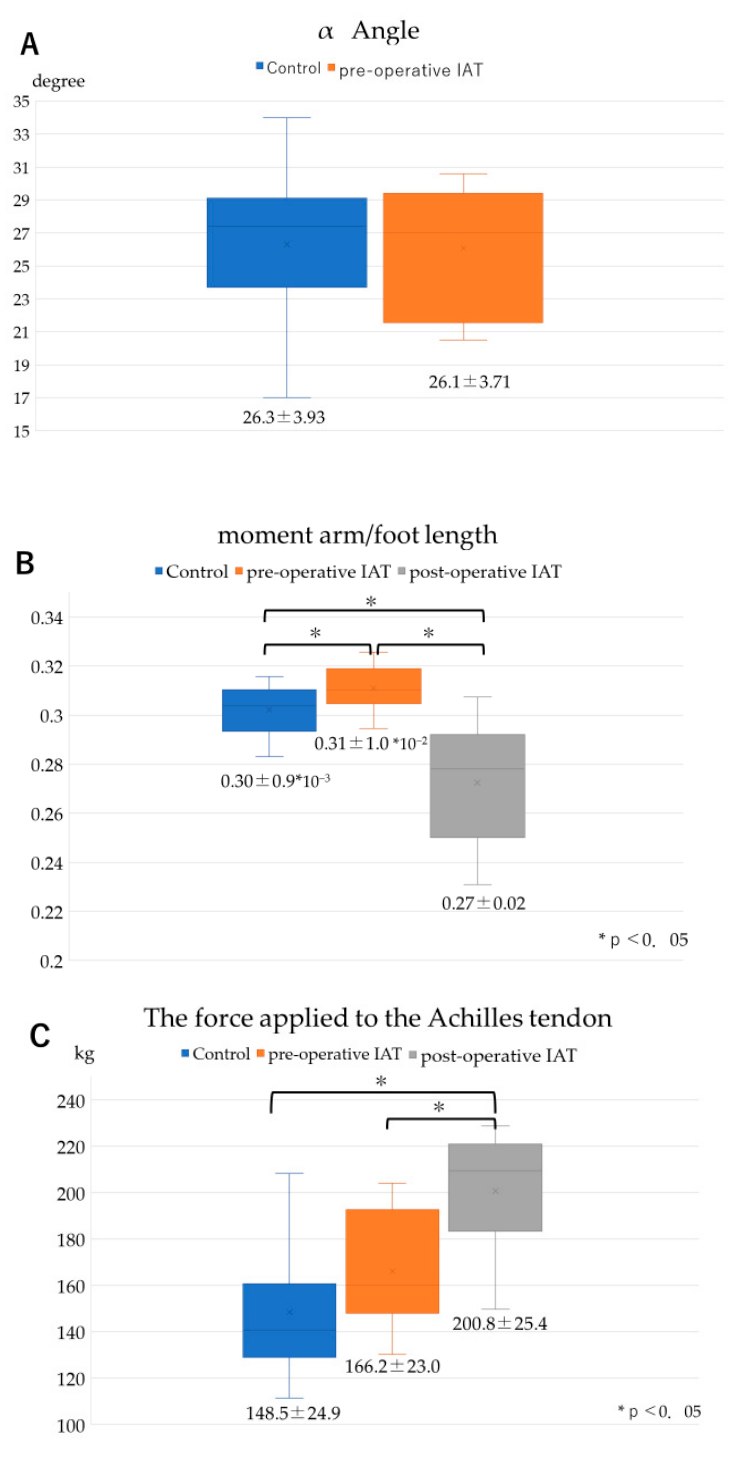
Figure 7. Radiographic Measurement. ( A ): Comparison of the α angle between the control and pre-operative IAT groups. ( B ): Comparison of the ratio of MA length / foot length between the control group, the preoperative IAT group, and the postoperative IAT group, showing significant differences between these groups ( p < 0.05). ( C ): Comparison of the force applied to the Achilles tendon between the control group, the preoperative IAT group, and the postoperative IAT group, showing that a significantly higher force to the Achilles tendon was observed in the IAT group postoperatively, compared to the other groups ( p < 0.05). Values are given as mean ± SD.